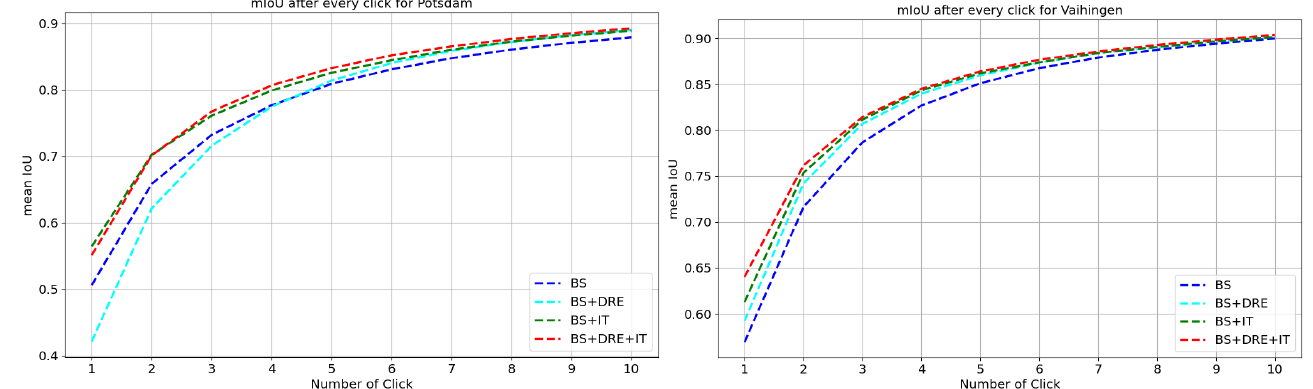
Figure 14. RoC ablation results for the Potsdam and Vaihingen datasets. The abbreviations “BS” and “IT” indicate the baseline and incremental training strategy, respectively.